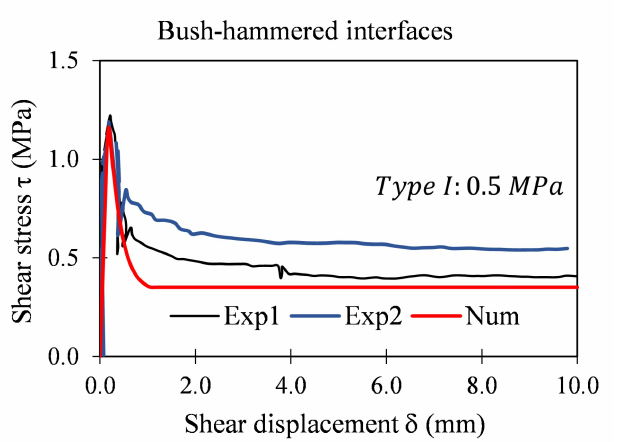
Figure 21. Experimental and numerical tests of bush-hammered interfaces (0.5MPa).